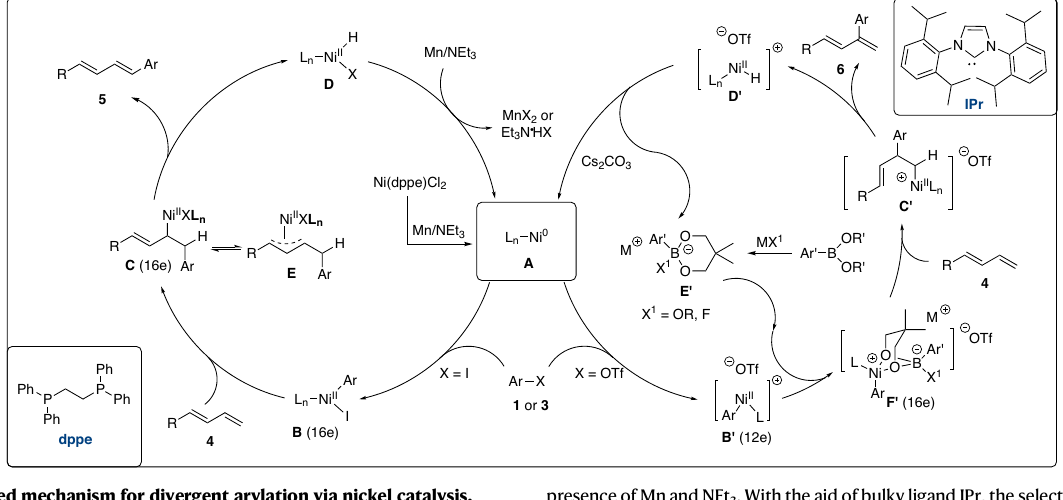
presenceofMnandNEt 3 .WiththeaidofbulkyligandIPr,theselectivityofreaction is switched to branched product 6 in presence of